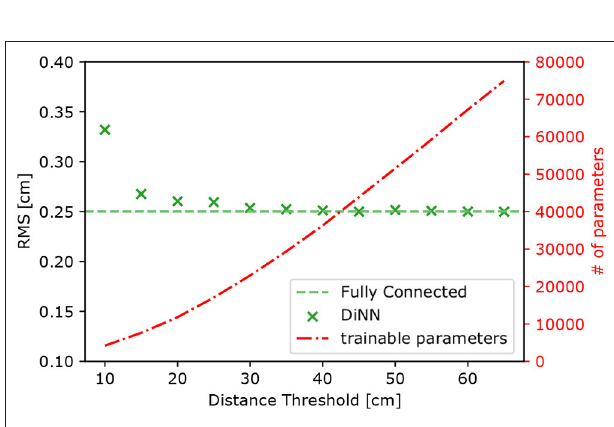
FIGURE 10 | The RMS of localization error (left axis) and the number of trainable parameters in the DiNN model (right axis) as functions of threshold used for the graph constrained layers in the model. The RMS decreases as the threshold increases until the threshold reaches 30 cm, but the number of parameter still increases as the threshold increases. The RMS is calculated on models’ prediction of simulated 100 electron S2s and averaged over x,y